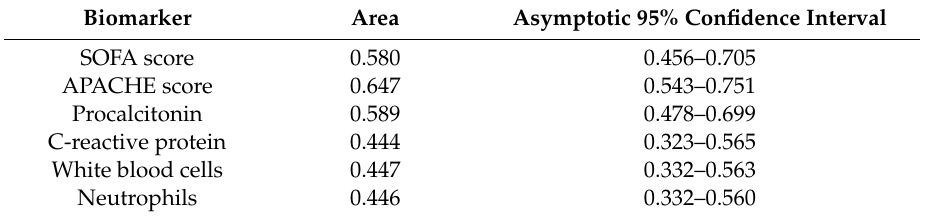
Figure 3. Quantification of mortality prediction accuracy by ROC AUC. ( a ) ROC AUC analysis of gene expression; ( b ) ROC AUC analysis of multivariate regression model that includes gene expression, emergency, sex, and age data, as well as creatinine, bilirubin, lactate, and white blood cell levels, as adjusted variables. ROC, receiver operating characteristic; AUC, area under the curve. Table 3. AUC values for different biomarkers.